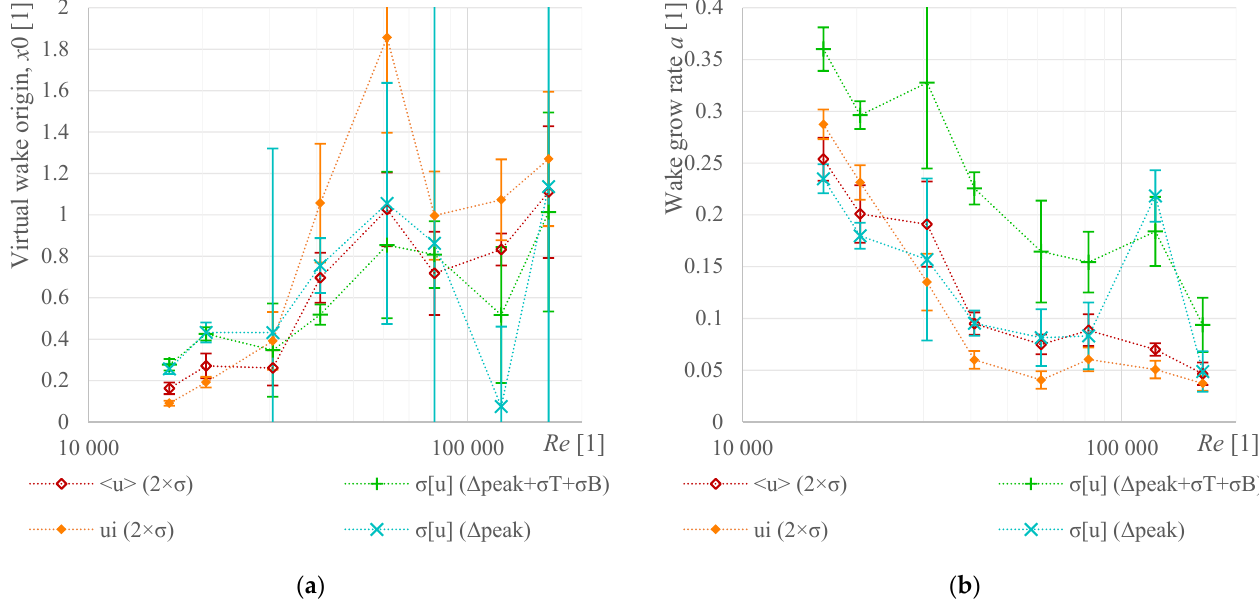
Figure 15. ( a ) Virtual origin x 0 of the wake width, if its stream-wise development is approximated by linear function (8). The uncertainty of flatness-based wake width is so high that it is not plotted. ( b ) the grow rate a of the wake as a function of Reynolds number. The symbols are the same as in Figure 14.